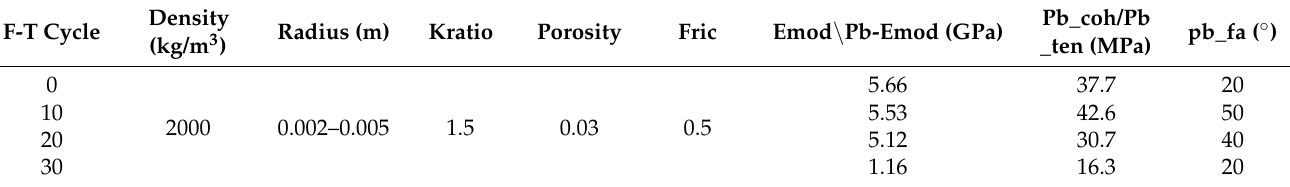
Table 6. Numerical simulation parameters under different freeze-thaw